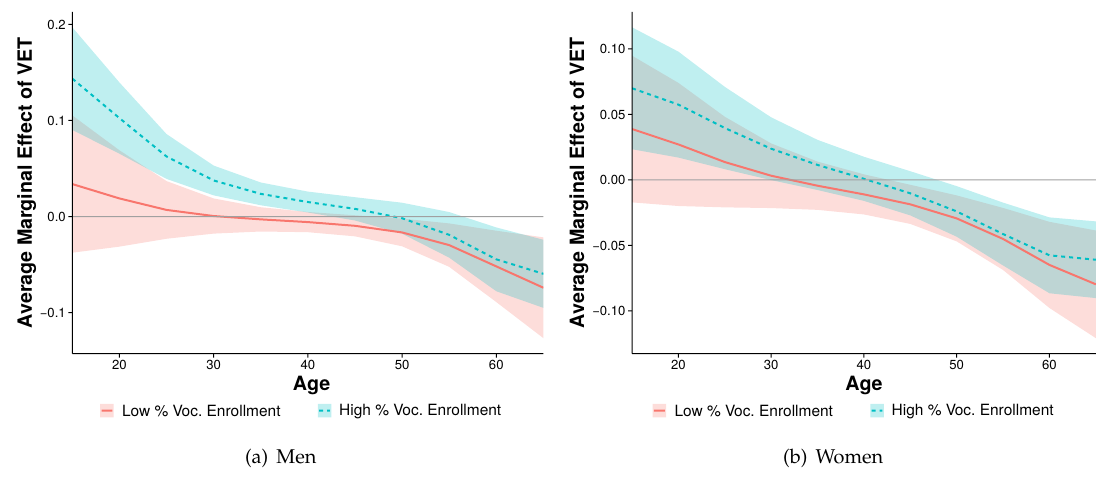
Figure3: Average marginal effect of VET on employment in countries with low and high vocational enrollment. Note: These graphs are based on the full model presented in Table 3. For the figures, age is used in its original form with years of age corresponding to values of the variable. Source: PIAAC 2012, release March 2015, own